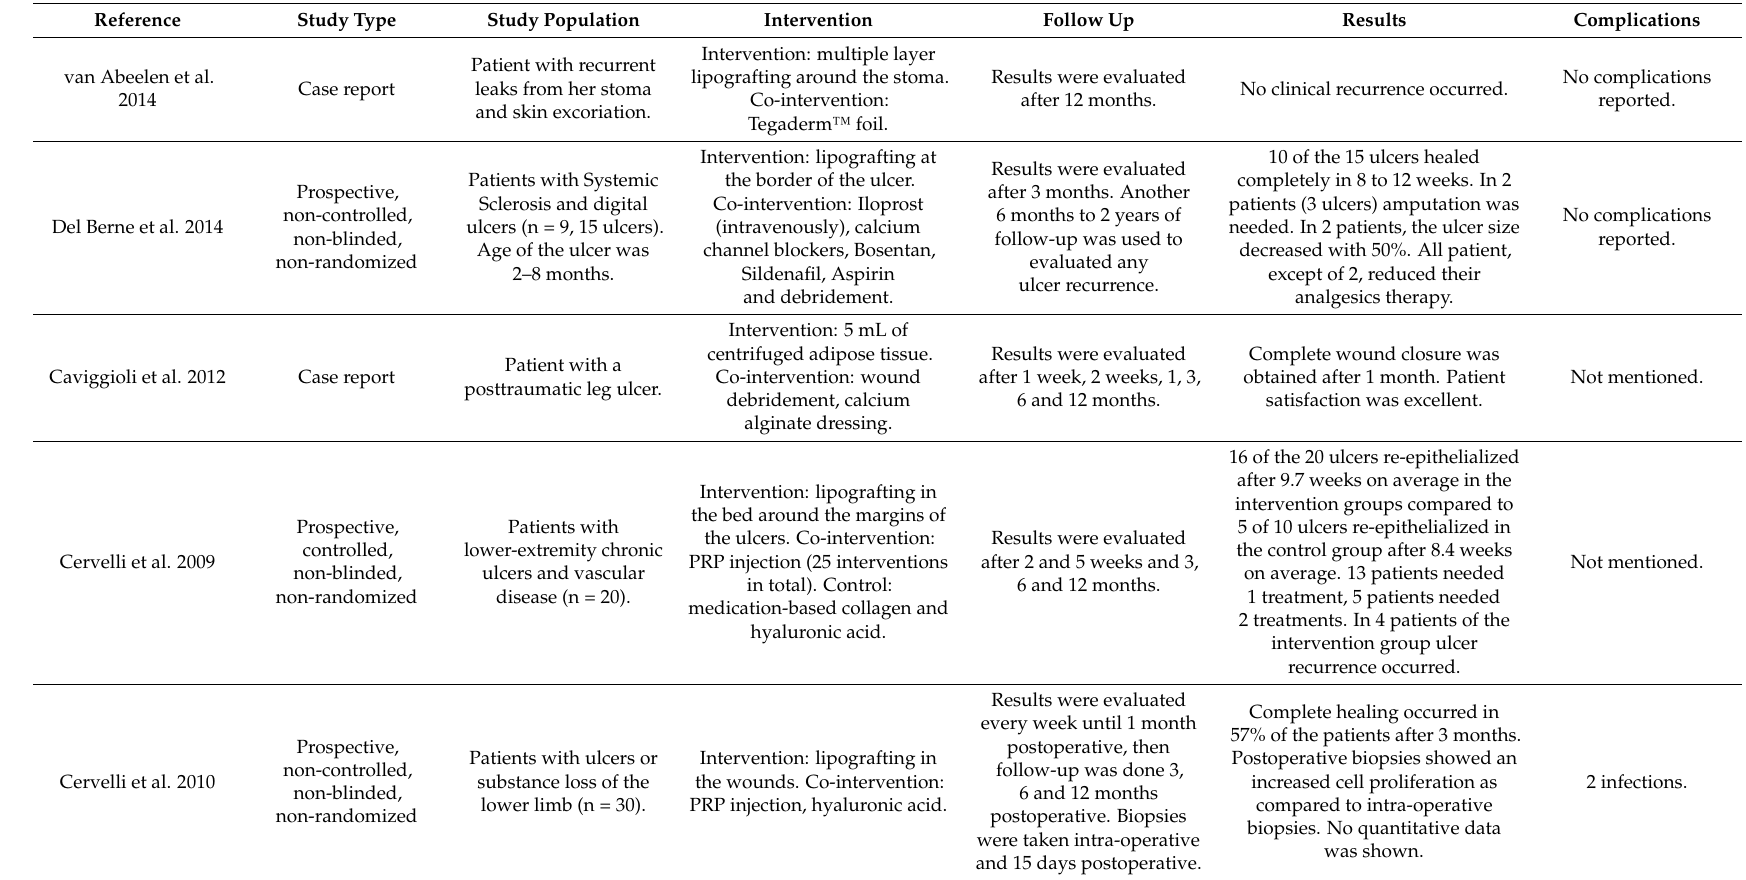
Table 3. Clinical studies of lipografting as treatment of wound